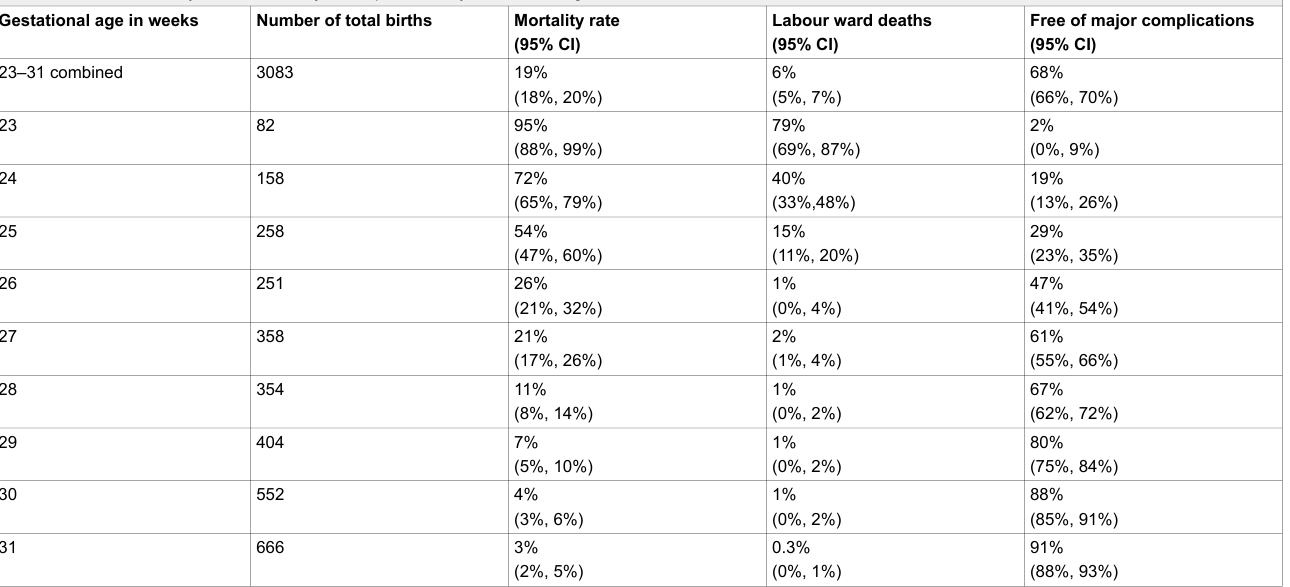
Table 2: Rates of Mortality and Free of Major Complications by Gestational Age. Gestational age in